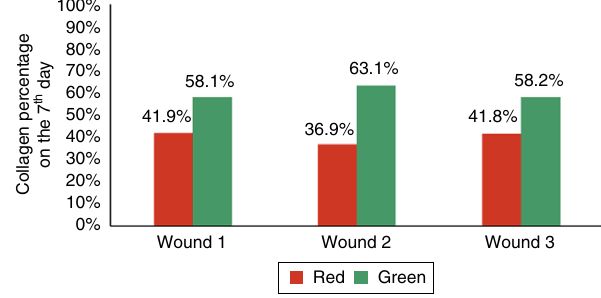
Demonstration of the percentage of type I and type III collagen on the seventh day of the experiment in the three wounds.